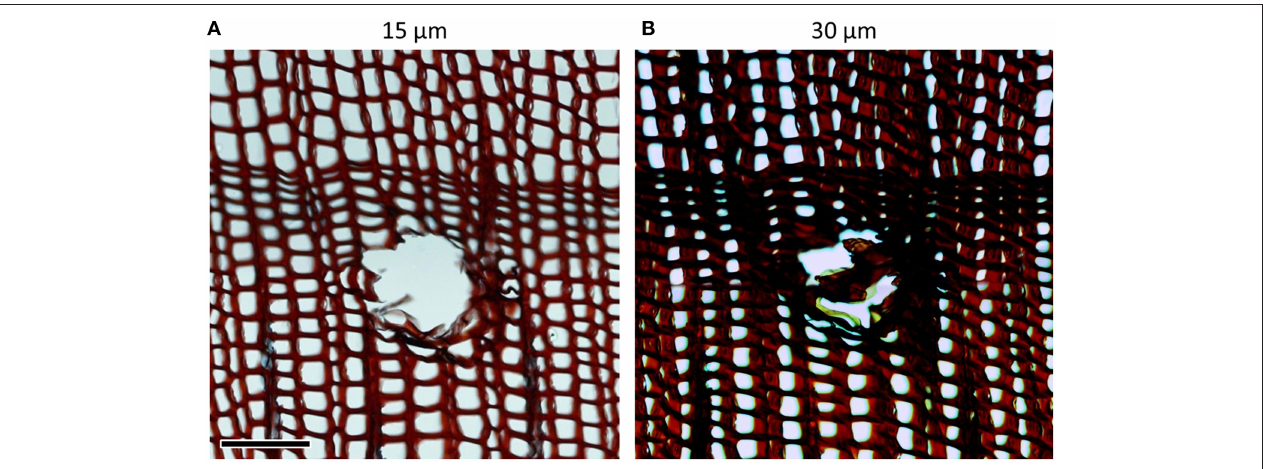
FIGURE 3 | Cross-sections of Pinus heldreichii cut from a not properly oriented sample, i.e., cutting direction that is not perpendicular to the axial tracheid orientation. Non-orthogonal cross-sections result in underestimation of lumen area and overestimation of cell wall thickness. These measurement errors are weaker in (A) thinner than in (B) thicker sections as revealed after analyzing the entire images (c. 2500 cells; only subset images shown here) with the image-analysis tool ROXAS (cf. Table 1 ): mean cell lumen area in (B) was 43% smaller and mean tangential cell wall thickness 46% larger than in (A) . Scale bar = 100 µ m.